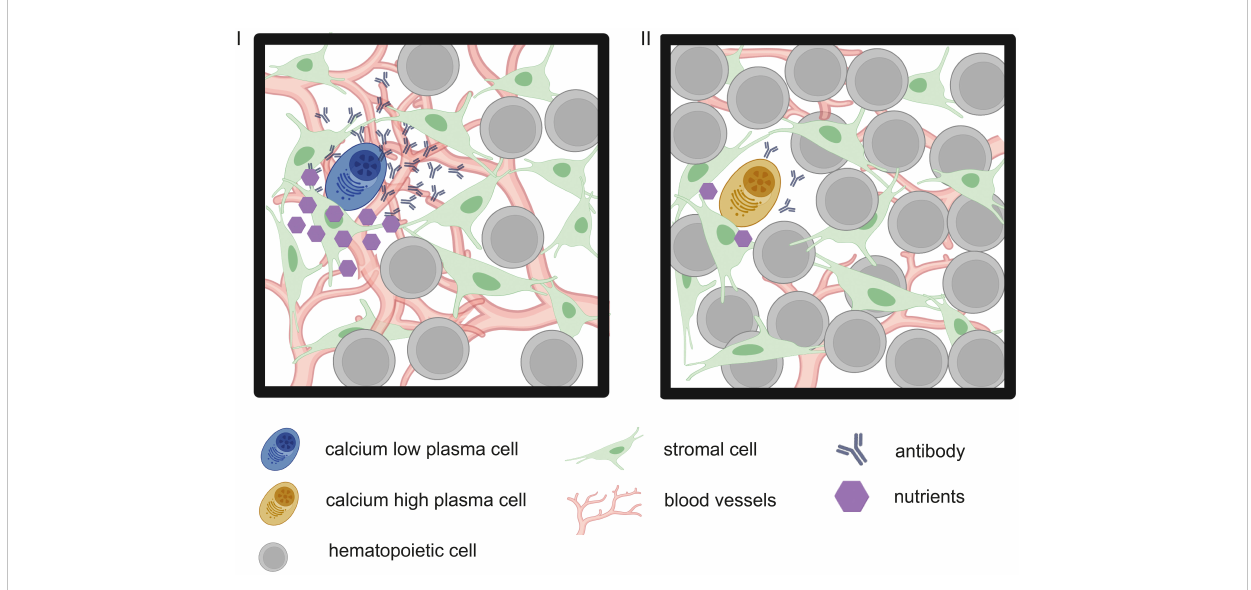
FIGURE 1 Graphic representation of two hypothetic metabolic states of PC within the BM, depending on niche composition. In this model, PC within their stromal cell niche (green mesenchymal stem cells) are low in cytoplasmic calcium (I, blue PC) in times of suf fi cient nutrient supply (purple hexagons), e.g. due to a dense vessel network (red branches) and only few other hematopoietic cells (grey), competing for nutrients. Calcium-low cells produce antibodies at high rates. Vice versa, in times of metabolic stress (II) through decreased nutrient supply due to hematopoietic nutrient sinks or vessel remodeling (5), antibody output is